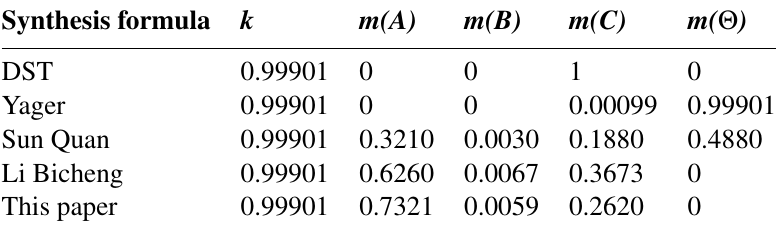
Table 1 Comparison of results of various evidence synthesis methods.